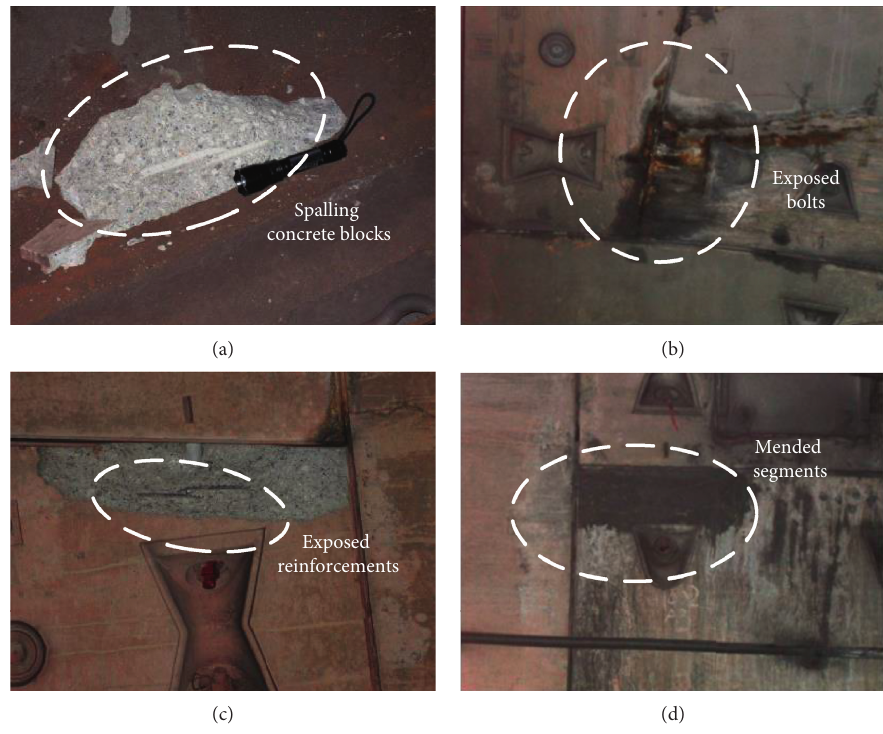
Figure 15: (a) Spalling blocks, (b) exposed bolts, (c) exposed reinforcements, and (d) mended segments.